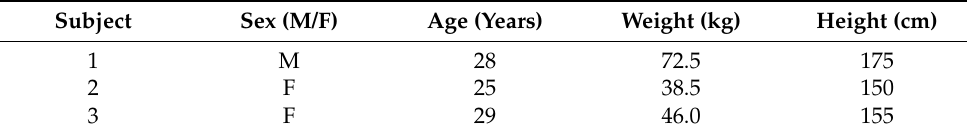
Table 1. Study participants’